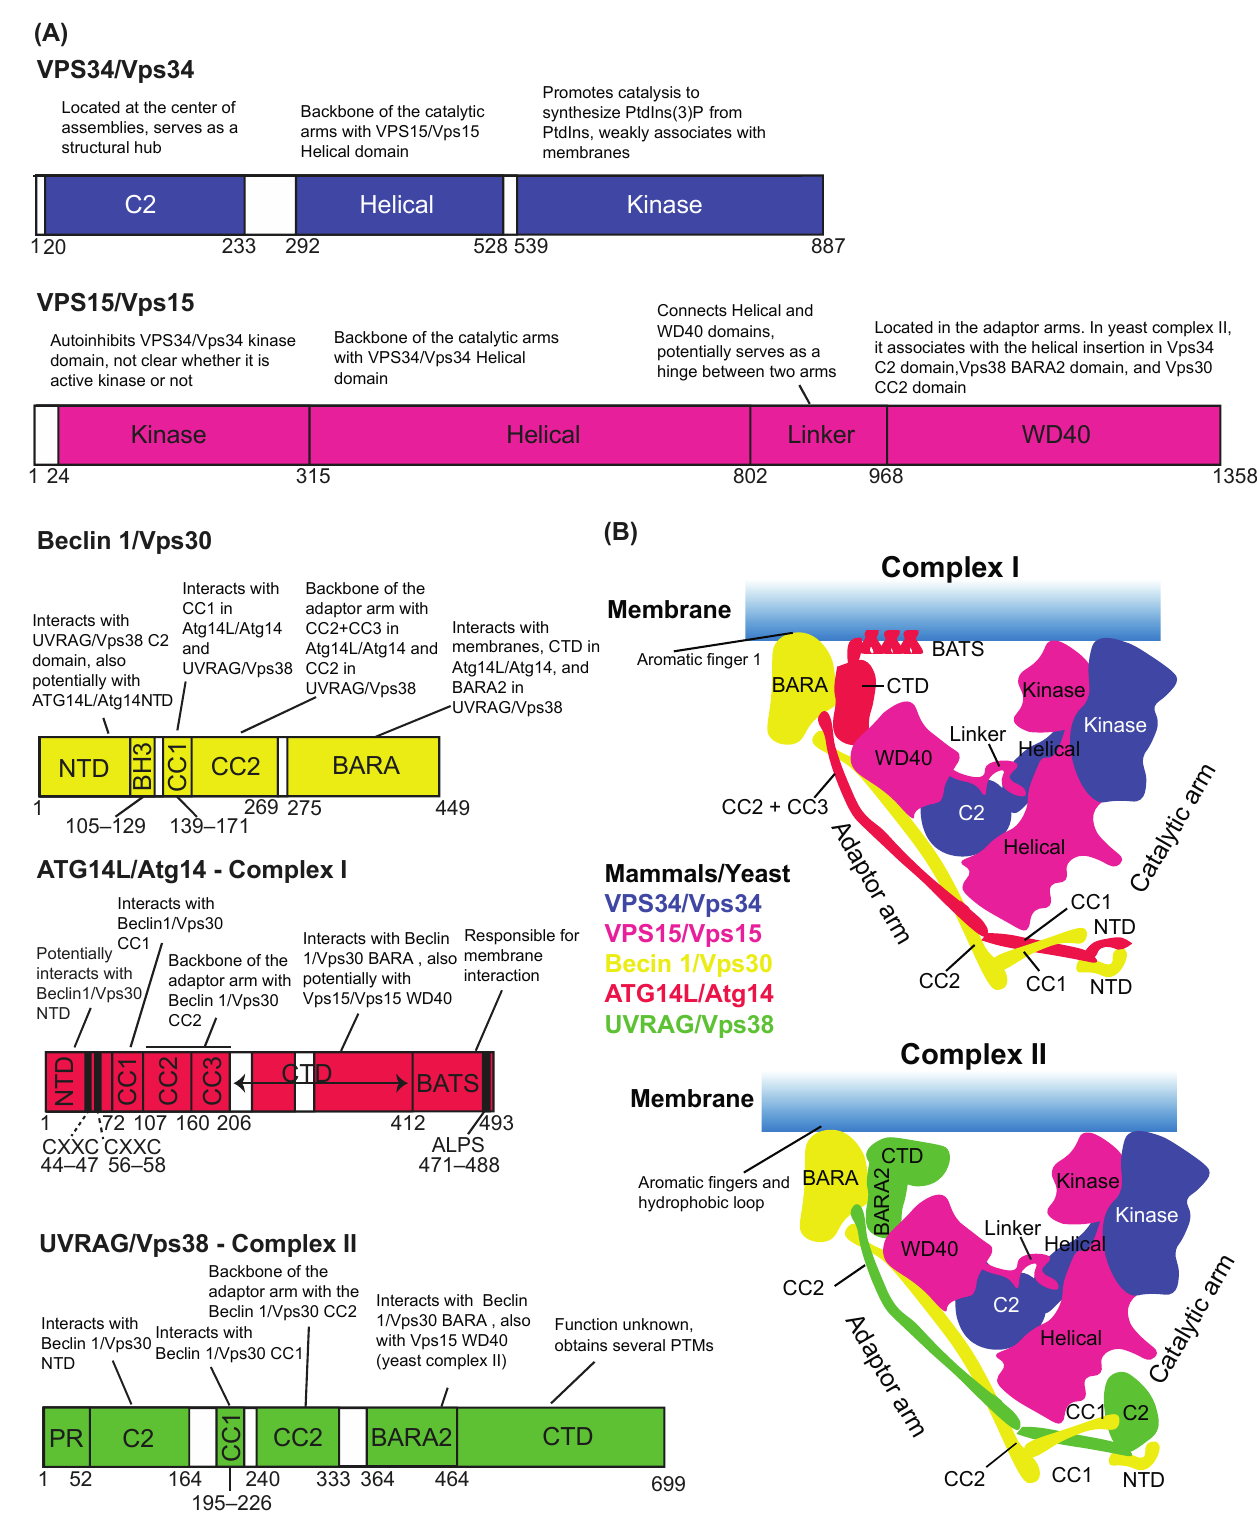
Figure 2. The role of each domain of VPS34/Vps34 complex I and II subunits in the assembly of the complexes. ( A ) Schematic representations of subunits in human numbers. ( B ) Structural schematic representations of complexes I and II. C2: C2 domain; CC: coiled-coil; BARA: β - α repeated, autophagy-specific (BARA) domain; BATS: Barkor/Atg14(L) autophagosome targeting sequence (BATS) domain; NTD: N terminal domain; CTD: C terminal domain; CXXCs: CXXC motifs; WD40: WD40 domain; PR: proline-rich domain; BH3: BH3 domain. The figures are modified from [34,35] .